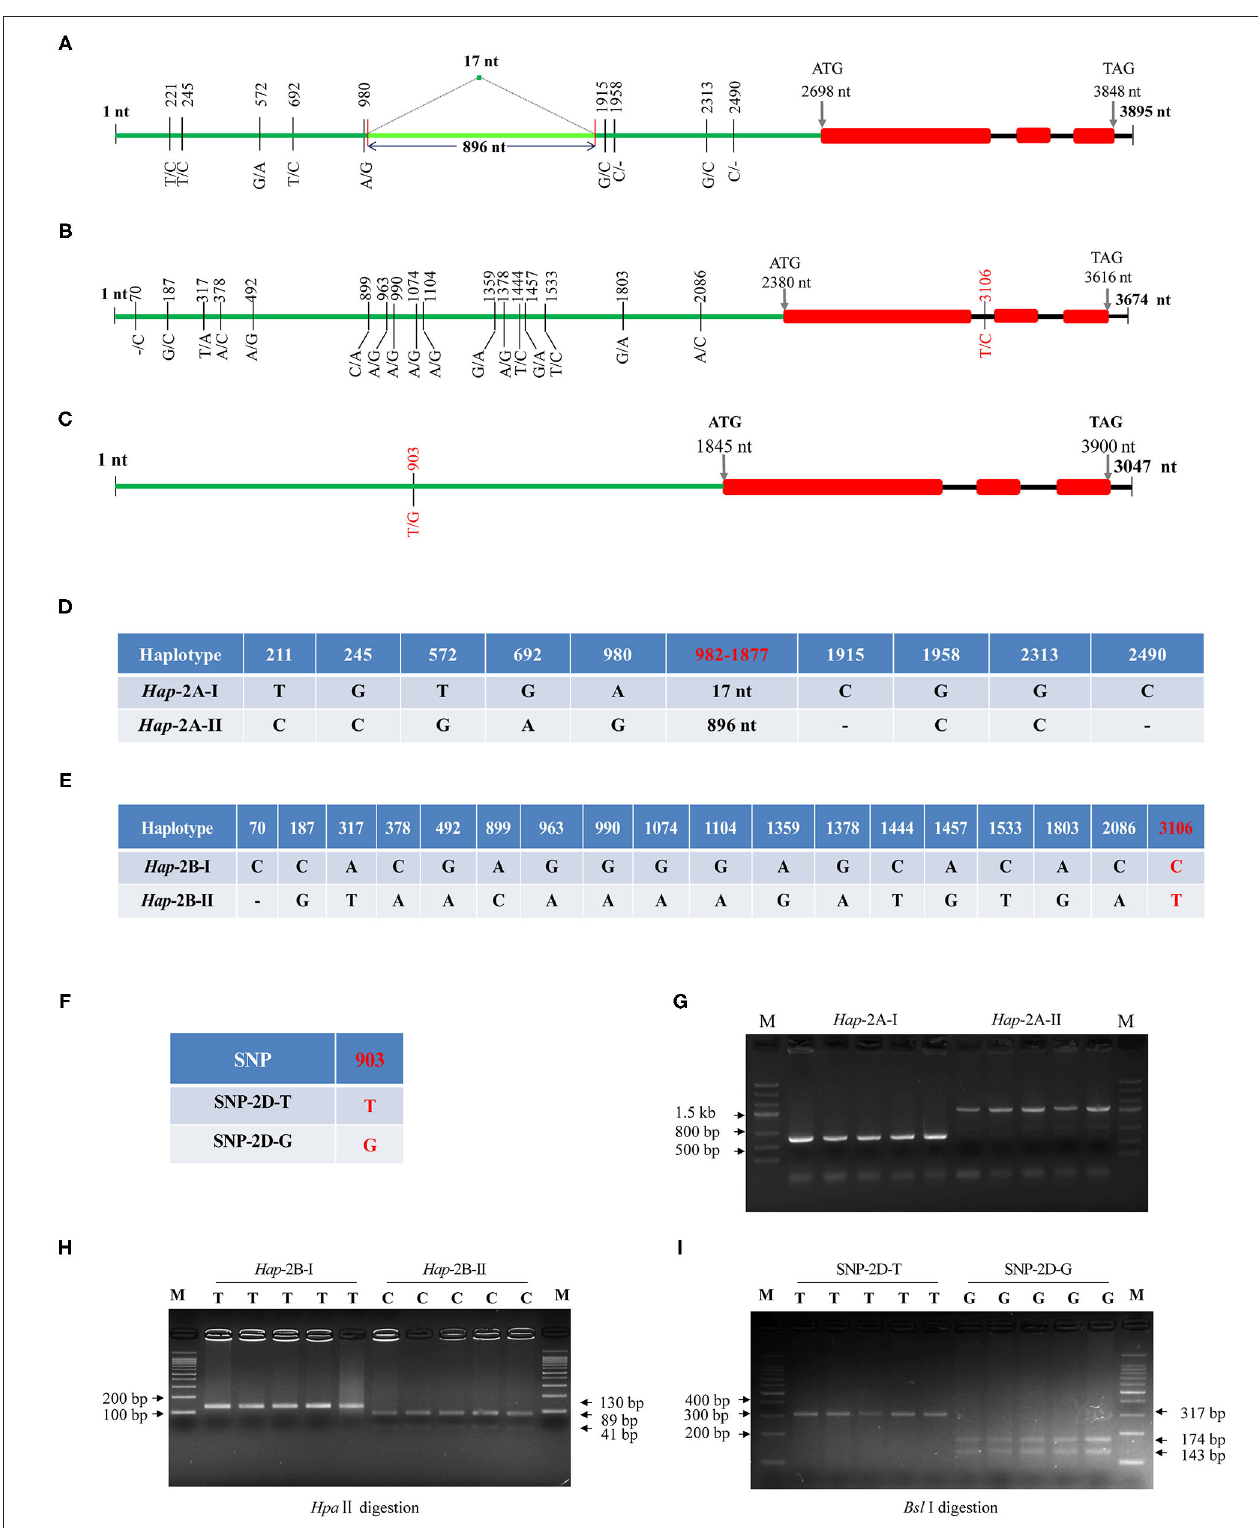
FIGURE 4 | Gene structures and DNA polymorphisms of TaWRKY51s . Gene structures and variation distributions of TaWRKY51-2A (A) , -2B (B) , and -2D (C) . The compositions of the haplotypes/alleles for TaWRKY51-2A (D) , -2B (E) , and -2D (F) ; functional marker for TaWRKY51-2A (G) , -2B (H) , and -2D (I) . The red numbers indicate the position where the functional markers were designed. The black lines indicate introns, red blocks indicate the exons of TaWRKY51s , green lines represent the upstream promoters. The size of blocks and lines is proportional to the length of the DNA sequence.